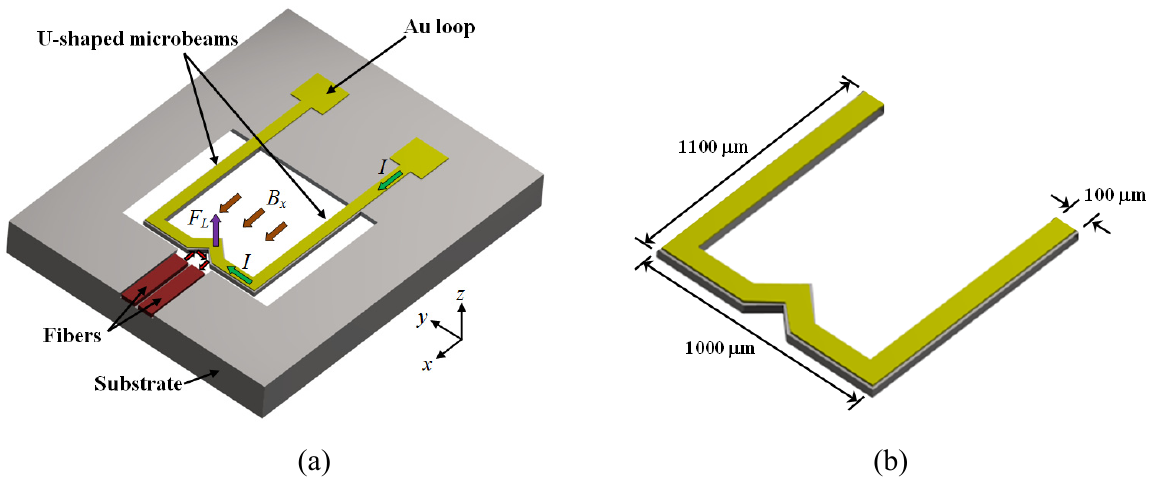
Figure 10. Schematic view of the magnetic field sensor with two parallel fibers and a cranked microbeam designed by Keplinger et al .